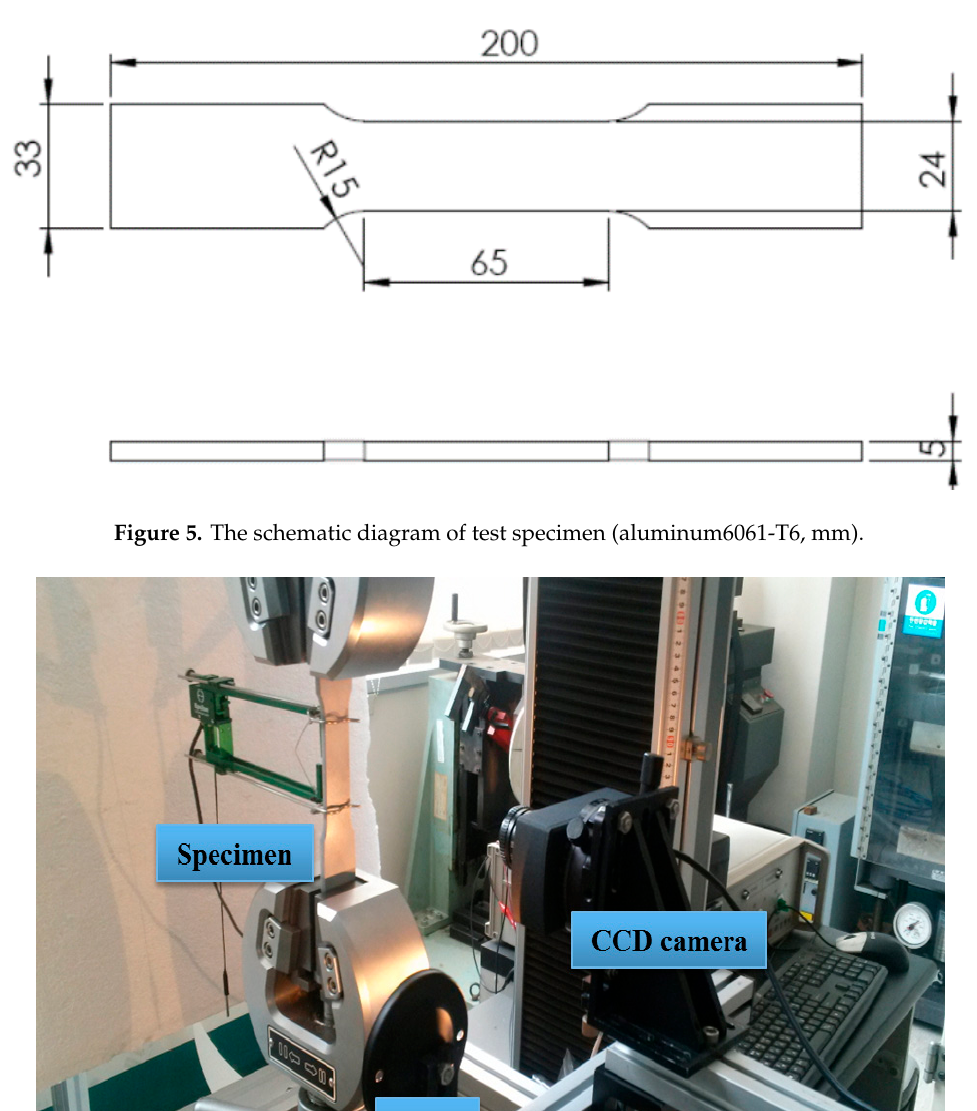
Figure 6. Photography of the tensile test using the universal test machine and DIC system.